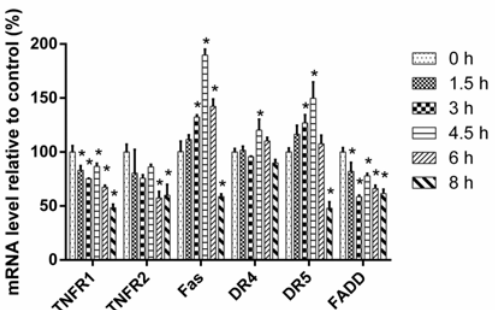
Figure 5. The relative mRNA expression results of DRs and FADD. Cells were treated with 16 µM of 3u for 0 h, 1.5 h, 3 h, 4.5 h, 6 h, and 8 h, and the mRNA relative expression level of DRs, FADD was detected by qPCR. The data were expressed as means ± SD ( n = 3). *, p < 0.05 vs. 0 h group (unpaired Student’s t